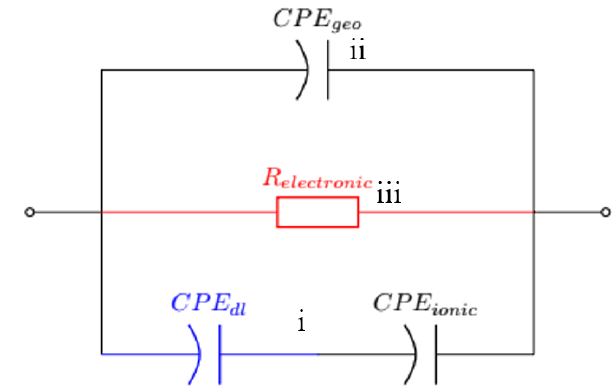
Figure 6. Proposed equivalent electrical circuit for humidity sens- ing in a broad temperature range. CPE dl is highlighted in blue be- cause it can only be fitted at room temperature. At high temperature this element is shorted. R electronic is highlighted in red because its only visible in the elevated temperature